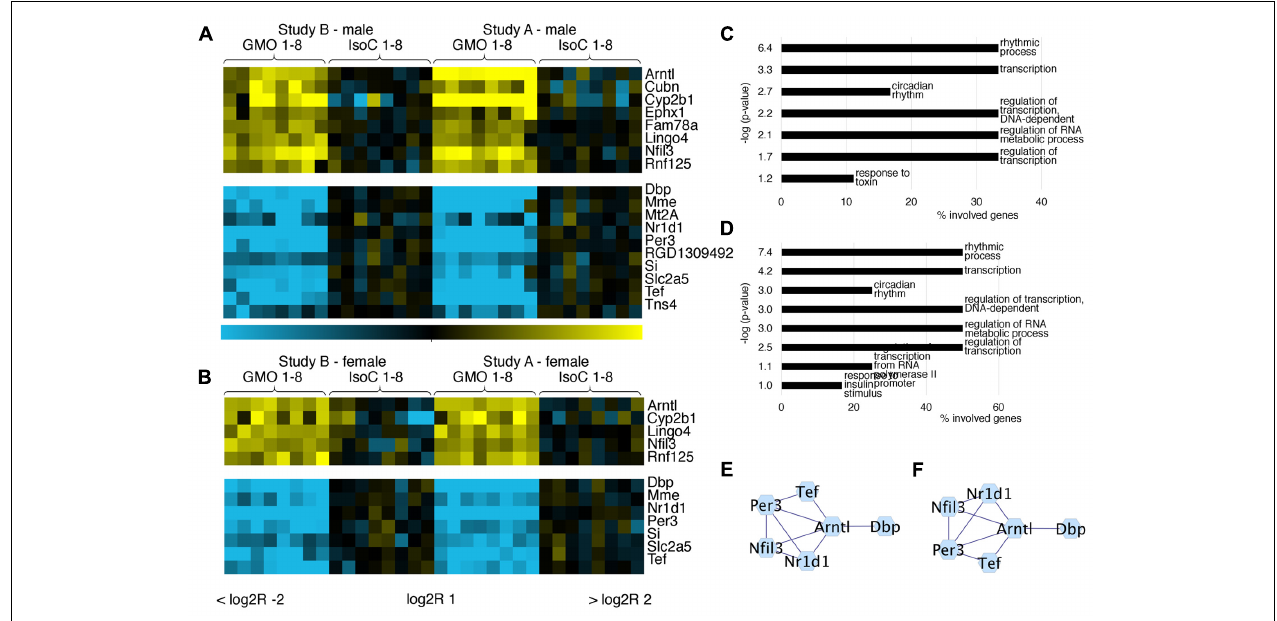
FIGURE 4 | Comparative analysis of commonly differentially expressed genes in both feeding trials. Heatmaps showing the top differentially expressed genes with more than twofold up/down-regulation ( q < 0.05) in ileum of male (A) and female (B) rats fed near-isogenic or GM maize. GO analysis of differentially expressed genes (log2R > 1 or < –1) in males (C) or females (D) indicates pathways with significantly regulated genes. Networks of protein-protein interactions in males (E) or females (F) showing associations in sets of differentially expressed genes.